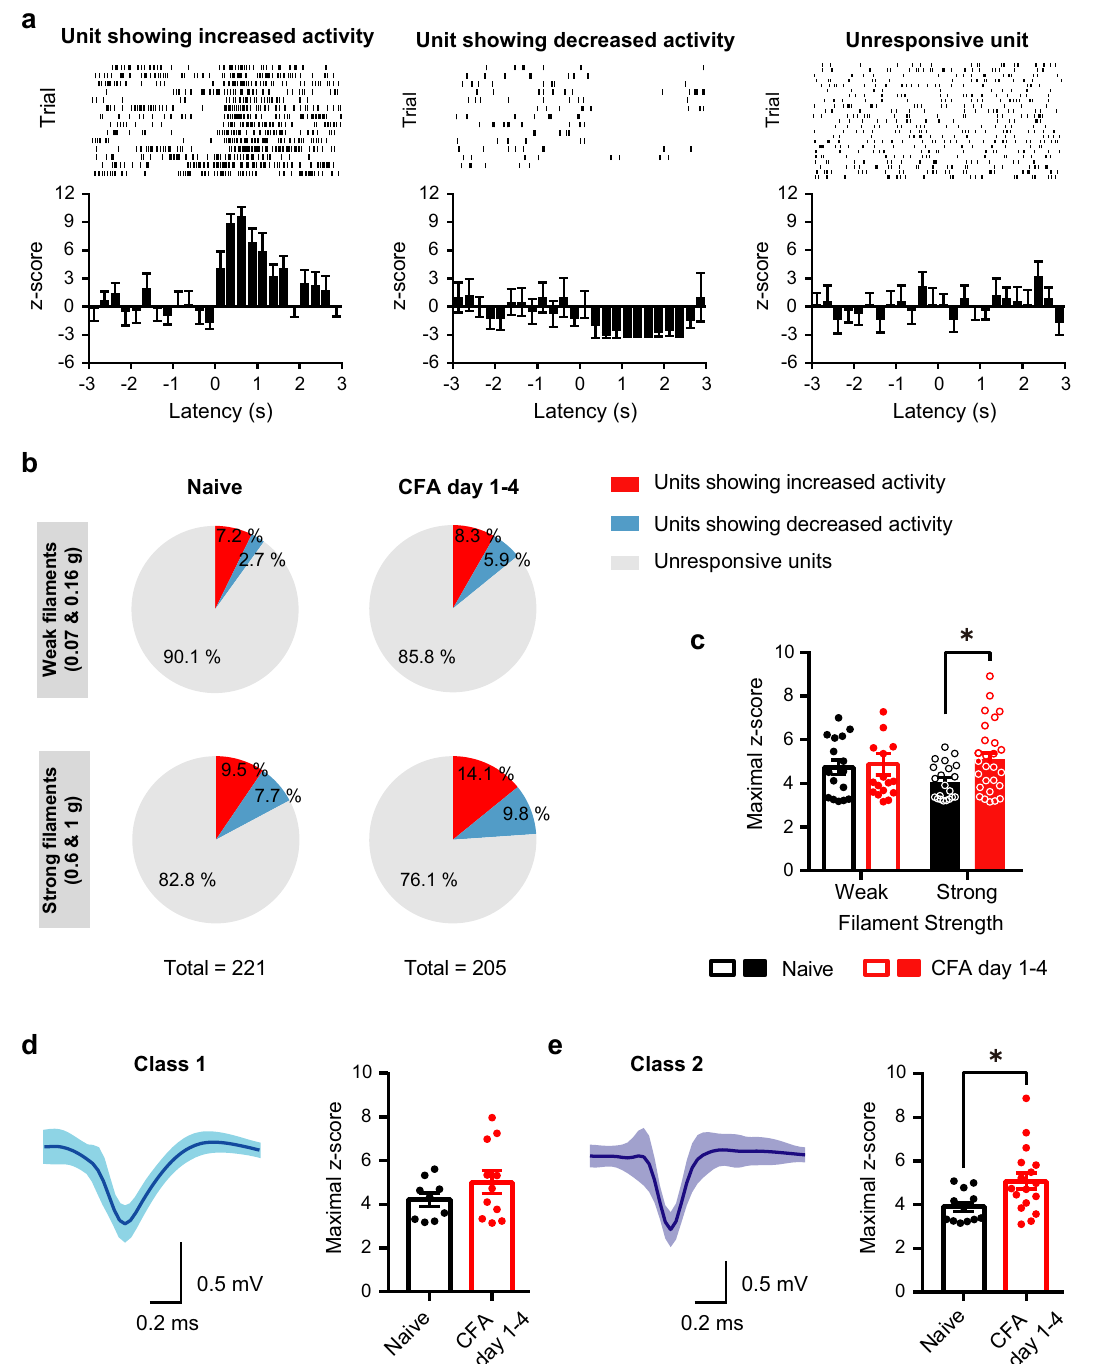
Fig. 3 | Resolving changes in NBM activity during acute nociception and in fl ammatory pain-like behavior at the single-cell level. a Typical examples (upper panels) and average z-scores, which represent the number of standard deviations for data points above or below mean, demonstrating NBM units that are excited by noxious stimulation of the paw (left-most panel), units that are suppressed in activity by paw stimulation (middle panel) and units that are not altered signi fi cantlyin activityfollowingpawstimulation. b Distribution ofNBM units responding to mechanical stimulation in naive (sham) conditions and